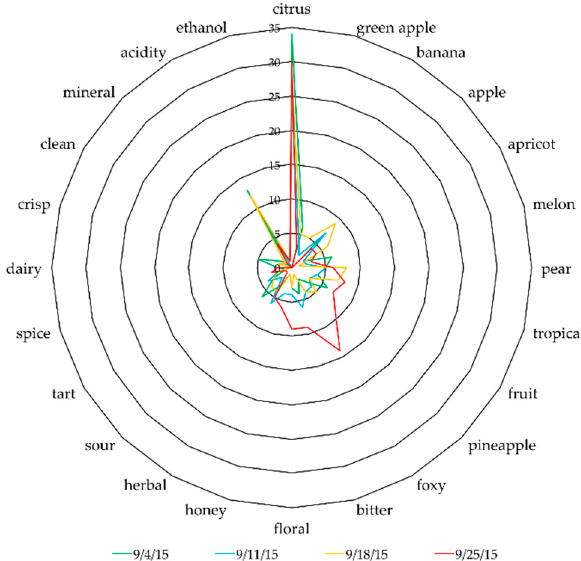
Figure. 5. A spiderplot indicating a shift of flavor and aroma descriptors of Brianna wines, that were made from grapes harvested from 4 September to 25 September, from the wine tasting panels generated by lay audiences at conferences for wine industry professionals. A shift of flavor and aroma descriptors is associated with the increase in °Brix and appearance of “foxy”, a negative characteristic associated with V. labrusca -based wines at the latest harvest